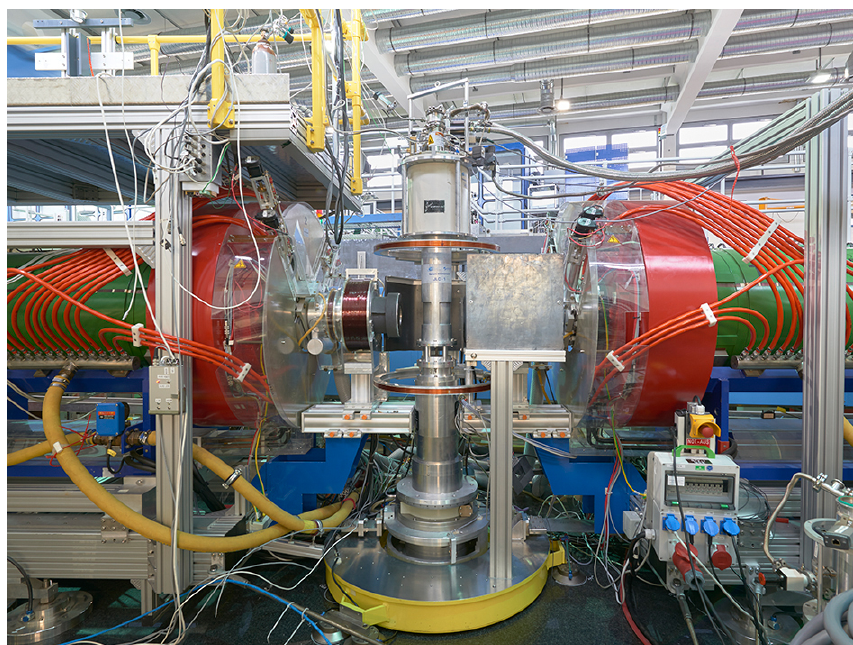
Figure 1: Sample position at the J-NSE instrument, front view (Copyright by W. Schürmann, TUM). Due to the intrinsic Fourier transform property of the NSE instrument it is especially suited for the investigation of relaxation-type motions that contribute at least several percent to the entire scattering intensity at the momentum transfer of interest. In those cases the Fourier transform property yields the desired relaxation function directly without numerical transformation and tedious resolution de- convolution. The resolution of the NSE may be corrected by a simple division. For a given wavelength the Fourier time range is limited to short times (about 2 ps for J-NSE set-up) by spin depolarisation due to vanishing guide field and to long times by the maximum achievable field integral J. The time is proportional to J x λ 3 . The J-NSE may achieve a J = 0.5 Tm corresponding to τ = 48 ns at λ = 8